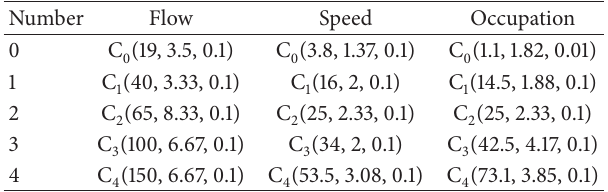
Table 6: Different cloud mode.